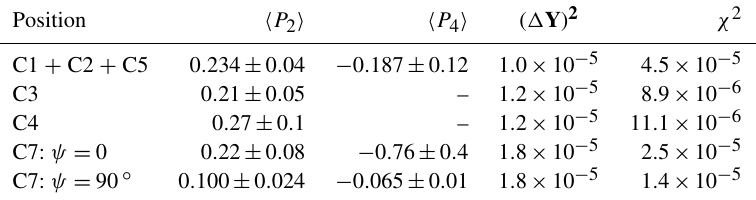
Table 3. Orientational moments of PC stretched by a factor of 1.45 as obtained from our analyses and indicators of fitting quality. Position (cid:104) P 2